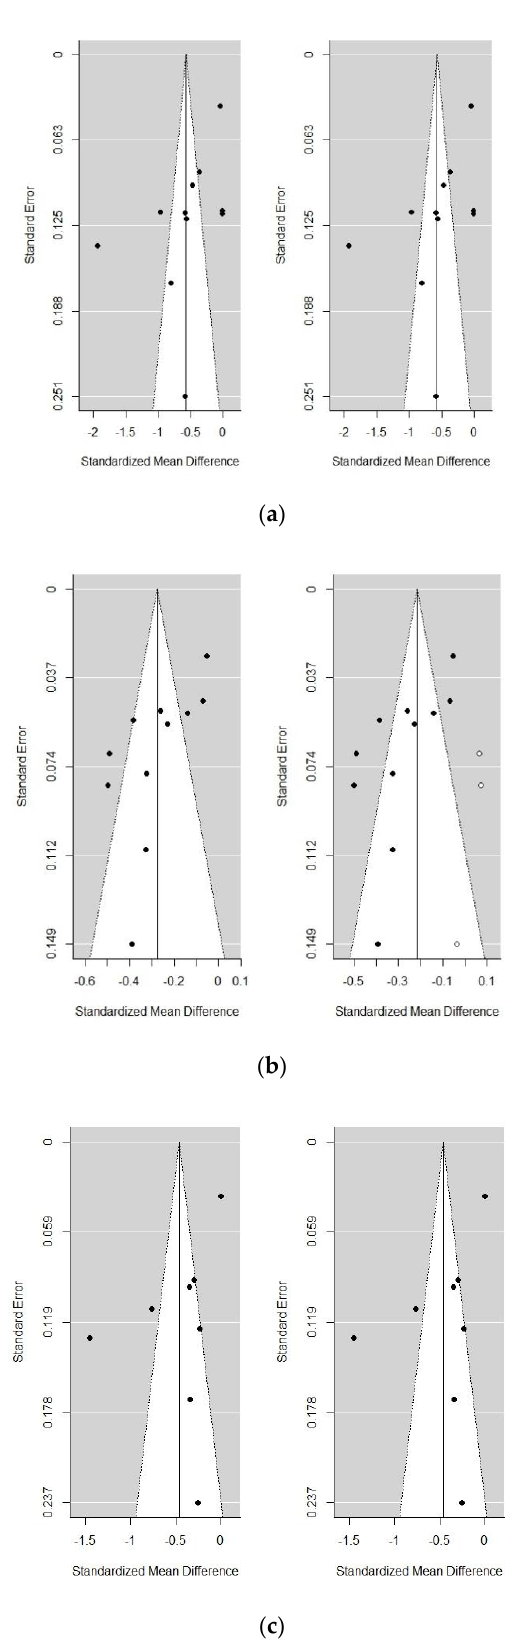
Figure 3. Funnel plots for 25(OH)D concentrations (sensitivity analyses excluding Smit et al. [18]). ( a ) frailty vs. non-frailty comparison, ( b ) pre-frailty vs. non-frailty comparison, and ( c ) frailty vs. pre-frailty comparison. Original data are shown on the left, and filled-in data in the trim-and-fill method on the